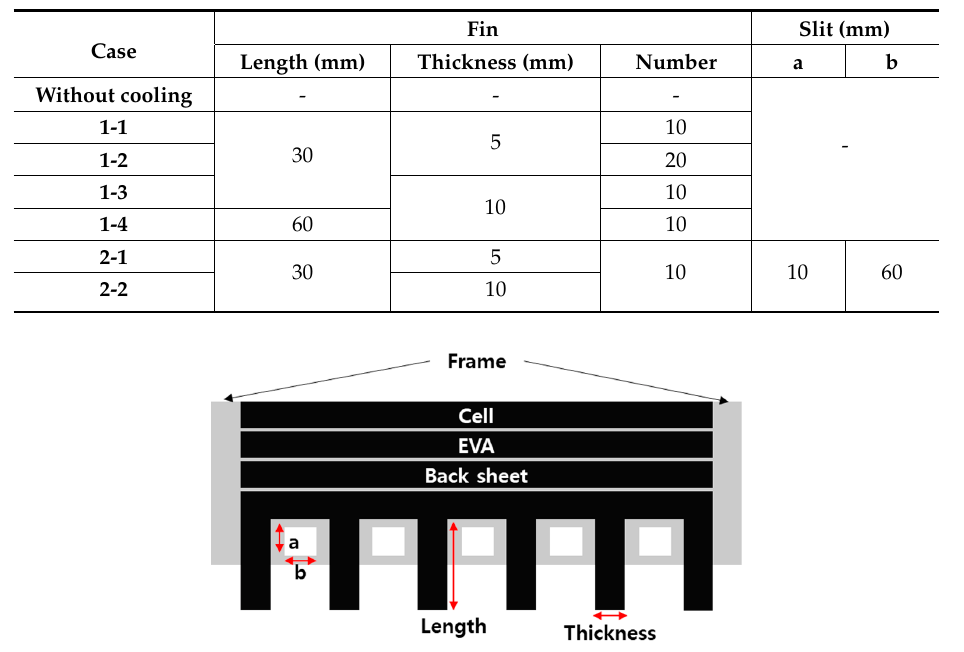
Table 5. Parameter study conditions.